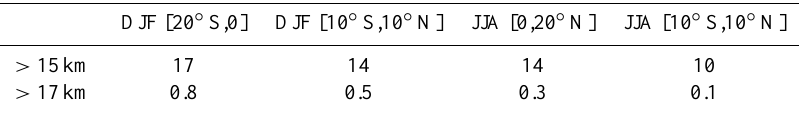
Fig. 2. Spatial distribution of deep convective cloud top pixels greater than 15 km (yellow) and greater than 17 km (red) during DJF (top) and JJA (bottom). The location of the SHADOZ station American Samoa is marked with a blue diamond. Table 1. Percentage of all deep convective cloud top pixels greater than a threshold height, within given latitude range. Based on CloudSat 2B-CLDCLASS data for the period June 2006–April